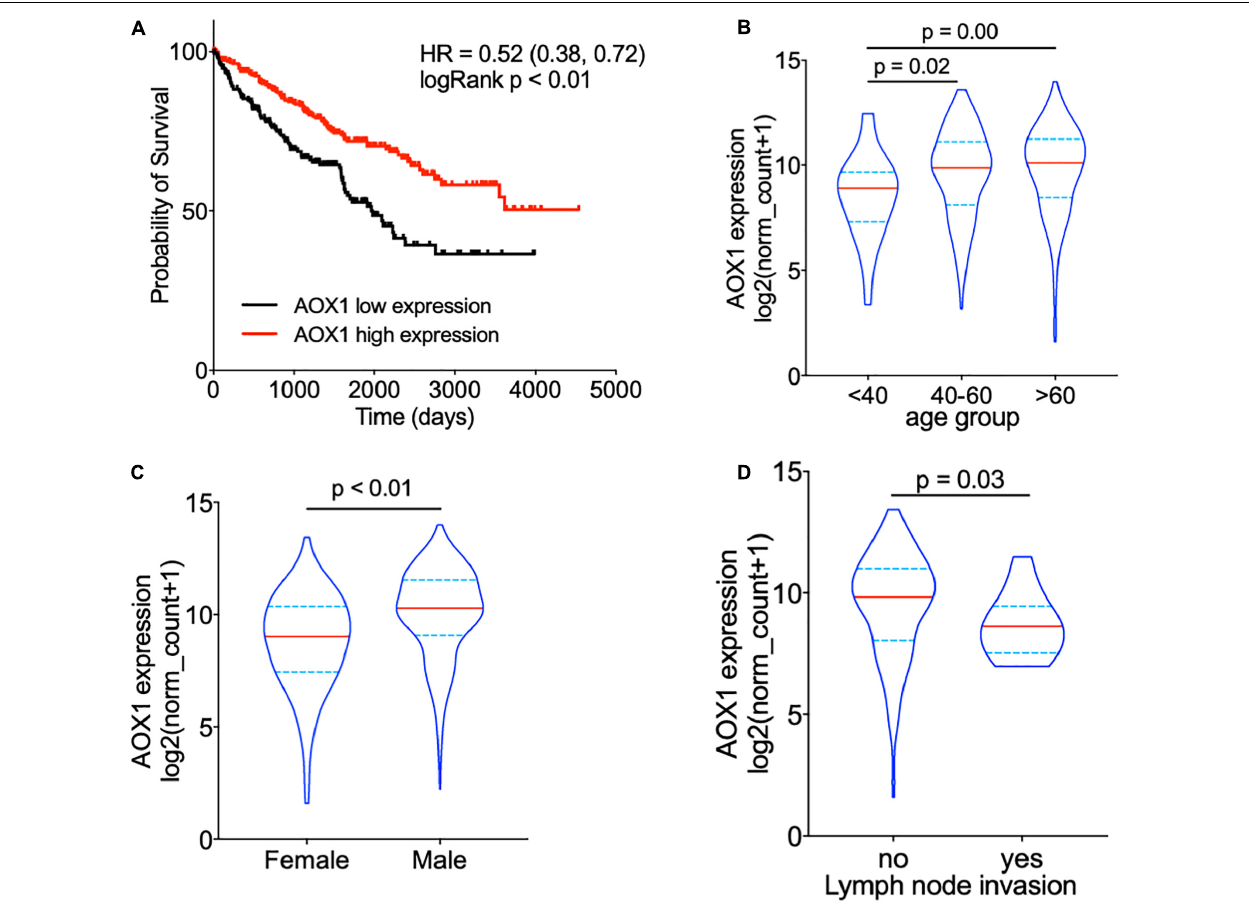
FIGURE 5 | AOX1 expression level correlates with overall survival and clinical factors of clear cell renal cell carcinoma (ccRCC) patients. (A) Kaplan–Meier curve showing ccRCC patients with higher AOX1 expression have better overall survival. AOX1 expression level was defined as low or high expression based on the mean of expression. HR, hazard ratio. (B) Violin plot showing significantly lower AOX1 expression in younger ( < 40 years old) ccRCC patients compared with older (40–60 or > 60 years old) ccRCC patients. n = 26, n = 235, and n = 265 for < 40, 40–60, and > 60 groups, respectively. (C) Quantification of AOX1 expression in different gender groups of ccRCC patients showing significantly lower AOX1 expression in female ccRCC patients. n = 185 and n = 341 for female and male, respectively. (D) Violin plot of AOX1 expression in ccRCC patients with (yes) or without (no) lymph node invasion. n = 236 and n = 13 for with or without lymph node invasion, respectively.